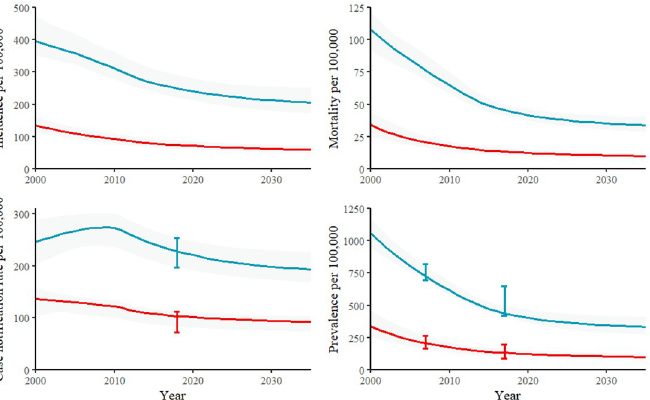
Fig 1. Epidemiological estimates and projections for men (light blue) and women (red) for incidence (top left), mortality (top right), case notification rate (bottom left), and prevalence (bottom right) for the calibrated model. Figures show median model estimates (line), model uncertainty (shaded area), and sex-specific calibration targets (error bars).